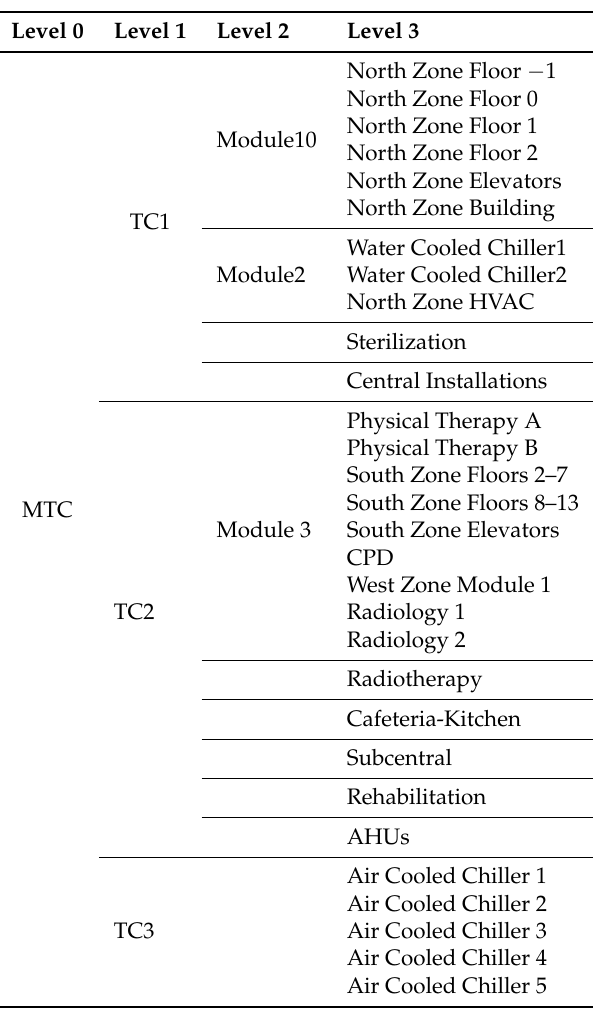
Table 1. List of the electrical meters and submetering architecture at the León University